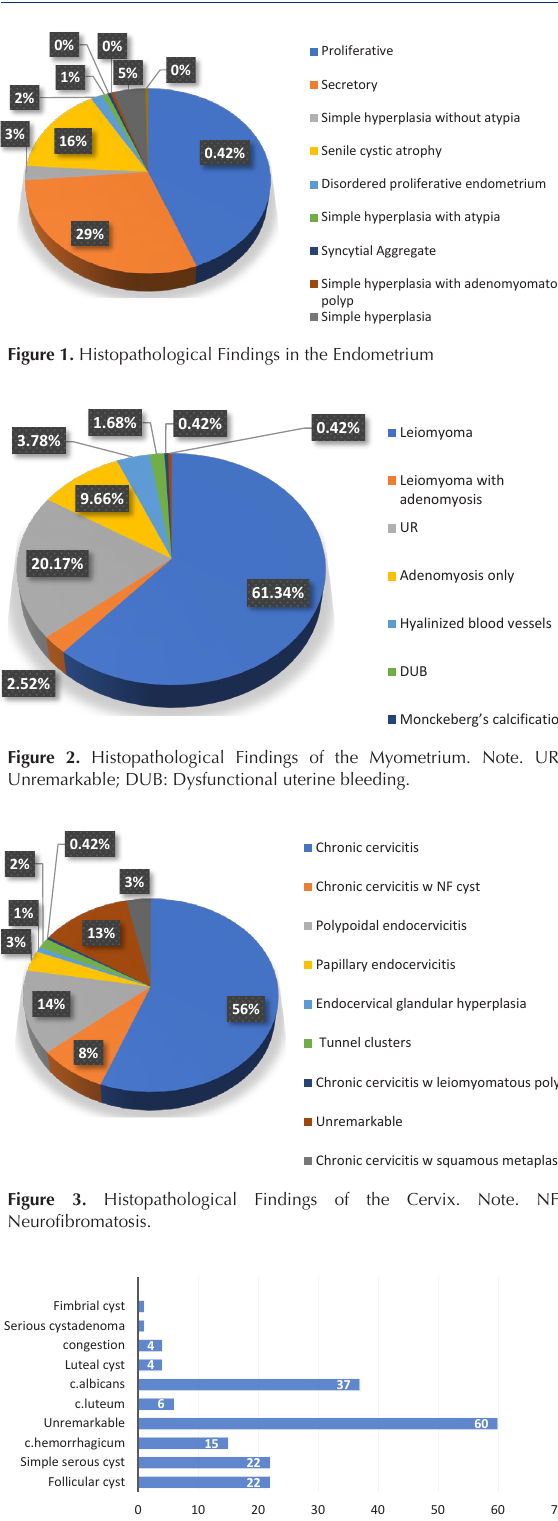
Figure 4. Histopathological Findings of the Ovary.